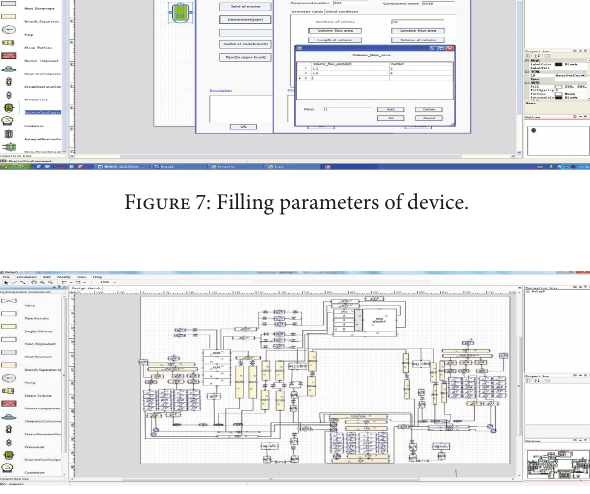
Figure 8: RELAP5-MV nodalization of